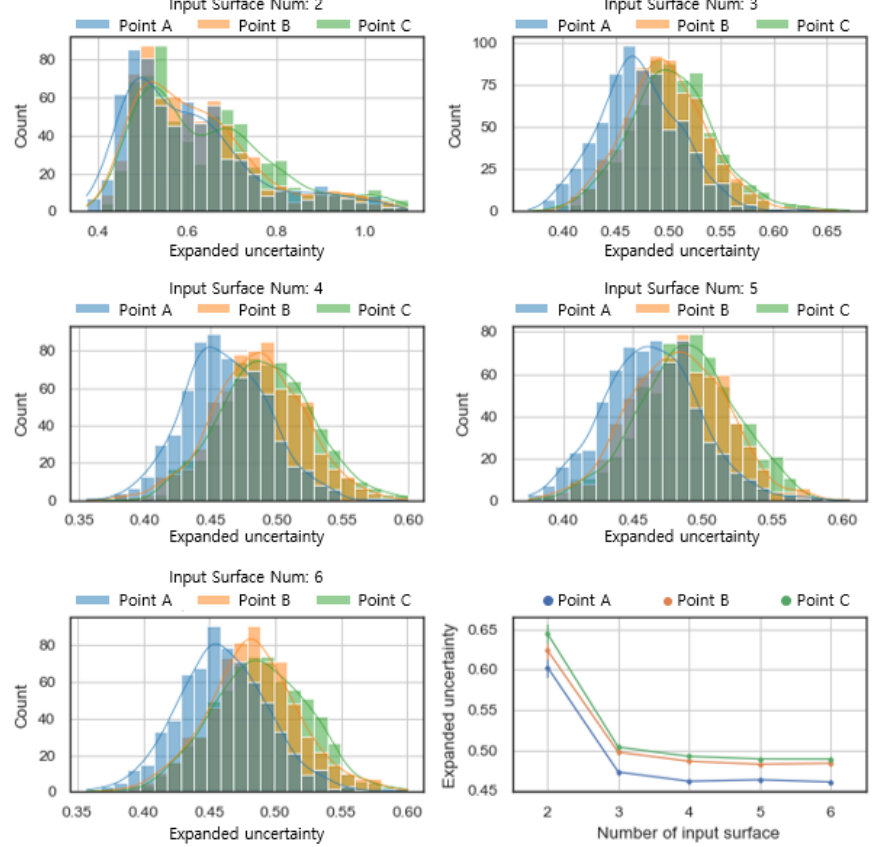
Figure 10. Histogram of expanded uncertainty of MRT calculation results.